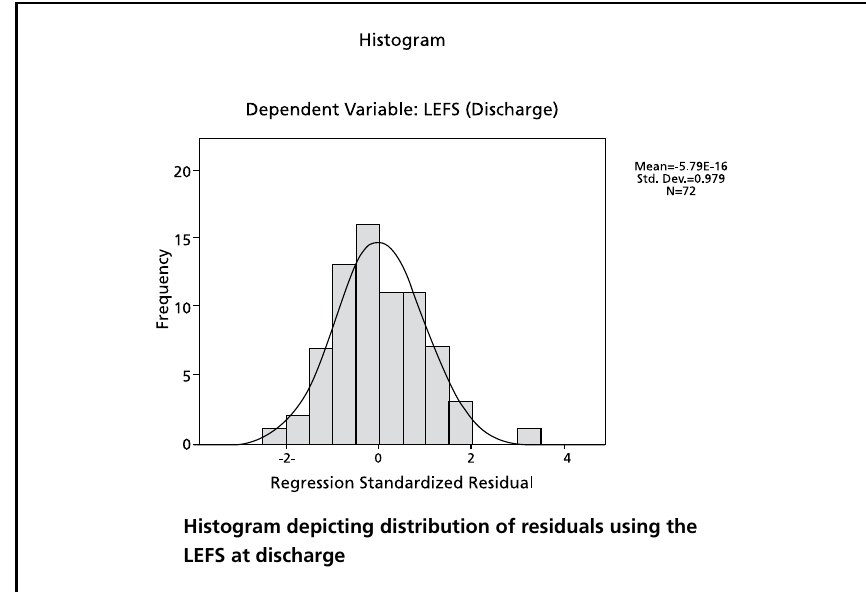
Figure 3: histogram depicting the distribution of variables using the lower extremity Functional scale at